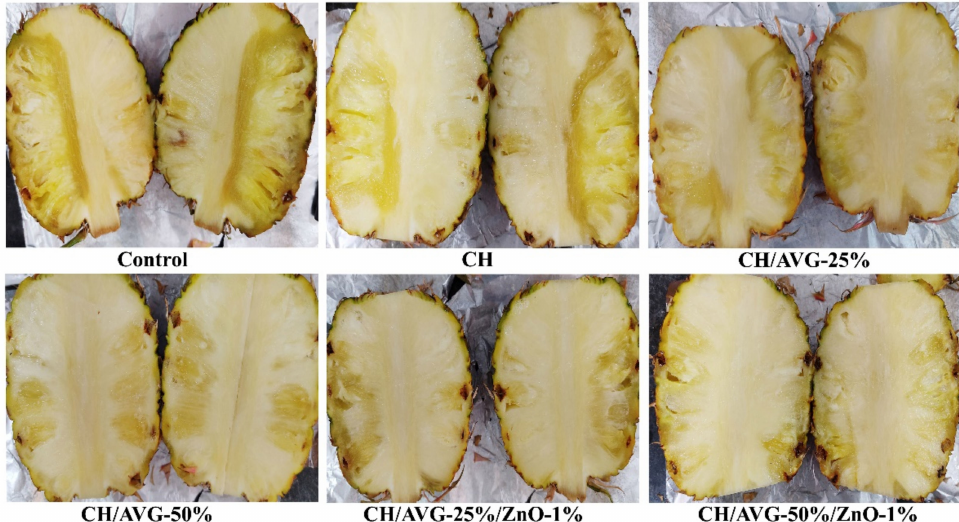
Figure 4. Effect of chitosan-based coatings on internal tissue damage and deterioration of pineapple fruits during 15 days storage under ambient